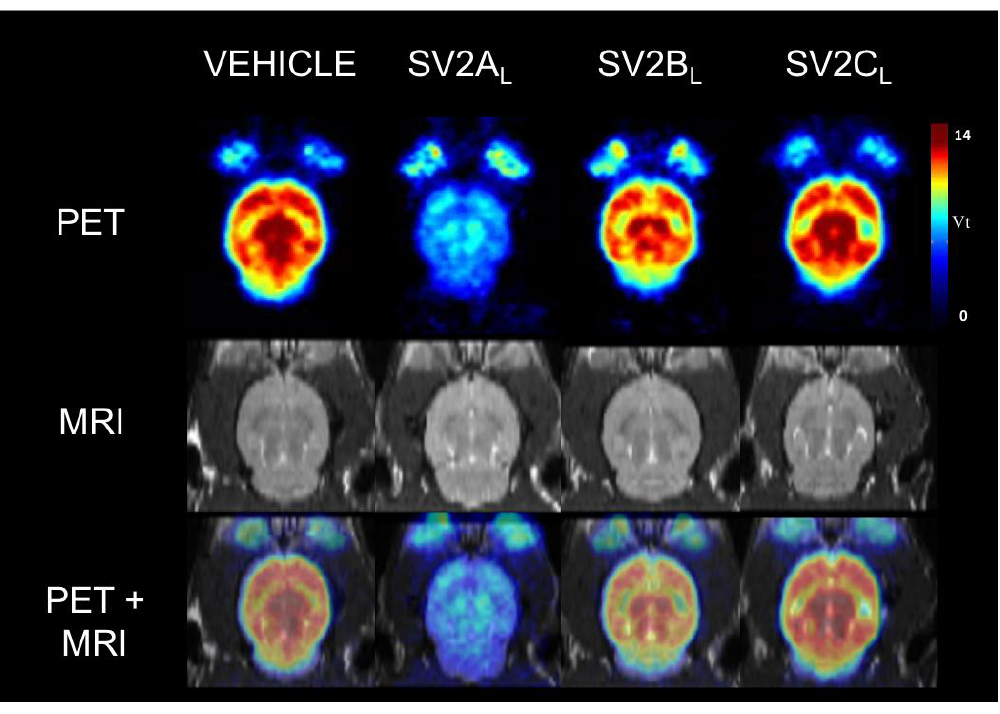
Figure 2. Example of an individual parametric Vt map of [ 18 F]UCB-H binding in rat brain (PET), along with the corresponding individual MRI and the overlay of both images (PET + MRI). Rats were pre-treated 30 min before the 60 min PET acquisition with either vehicle, SV2A competitor (levetiracetam [SV2A L ] at 10 mg / kg), SV2B competitor (UCB5203 [SV2B L ] at 3 mg / kg) and SV2C competitor (UCB0949 [SV2C L ] at 3 mg / kg).